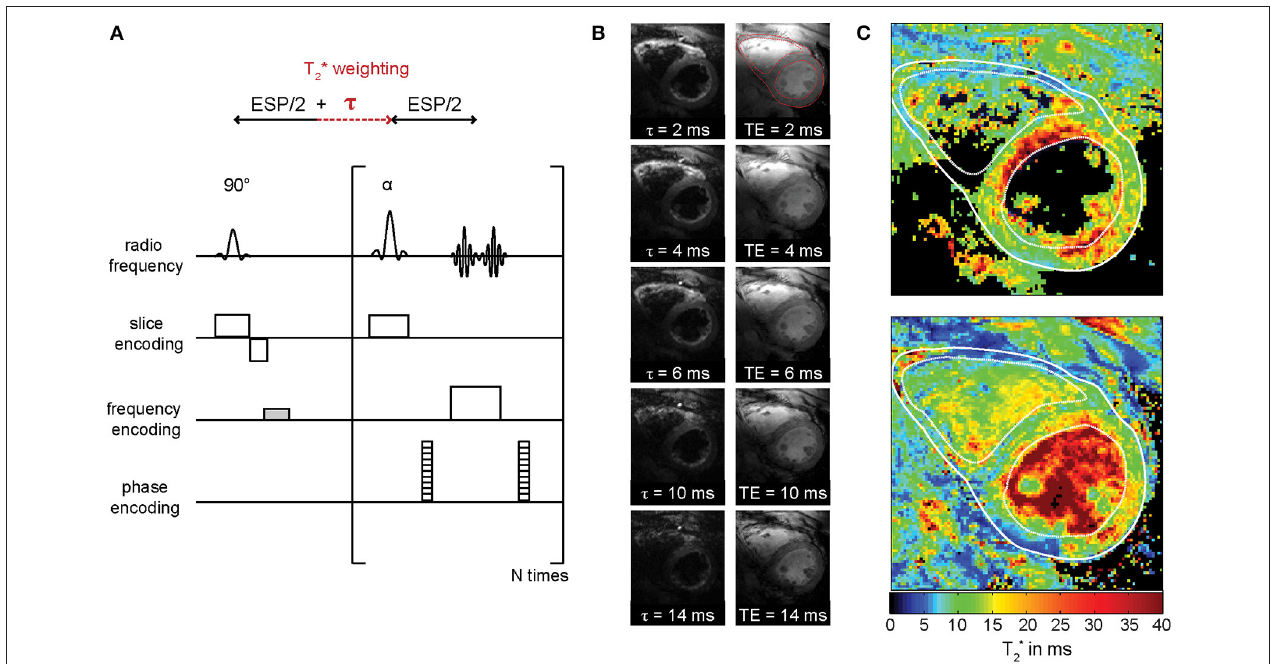
FIGURE 7 | RARE-based myocardial T 2 * mapping at 7.0 T. (A) Basic pulse sequence diagram of T 2 * weighted split-echo RARE. T 2 * weighting is introduced into RARE by adding an evolution time τ after the excitation RF pulse. The dephasing gradient in frequency encoding direction is imbalanced (marked in gray) to avoid destructive interferences between odd and even echo groups. (B) T 2 * -weighted split-echo RARE images of a short axis view employing evolution times ranging from τ = 2 ms to τ = 14 ms (left). MEGRE images obtained with echo times ranging from 2 to 14 ms (right). For improved visualization, the images do not exhibit identical windowing over the range of increasing susceptibility weighting. The myocardium was delineated and the contour is shown in the images with minimal τ /TE. (C) T 2 * maps derived from data in shown in (B) are depicted for the RARE (top) and the GRE (bottom) approach. The contours defined in the images with minimal τ /TE were copied to the T 2 * maps for better delineation of the